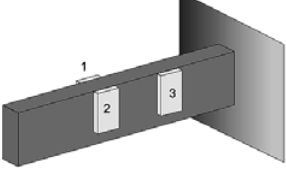
Fig. 1. Flexible beam and its piezoelectric patches – Schematic